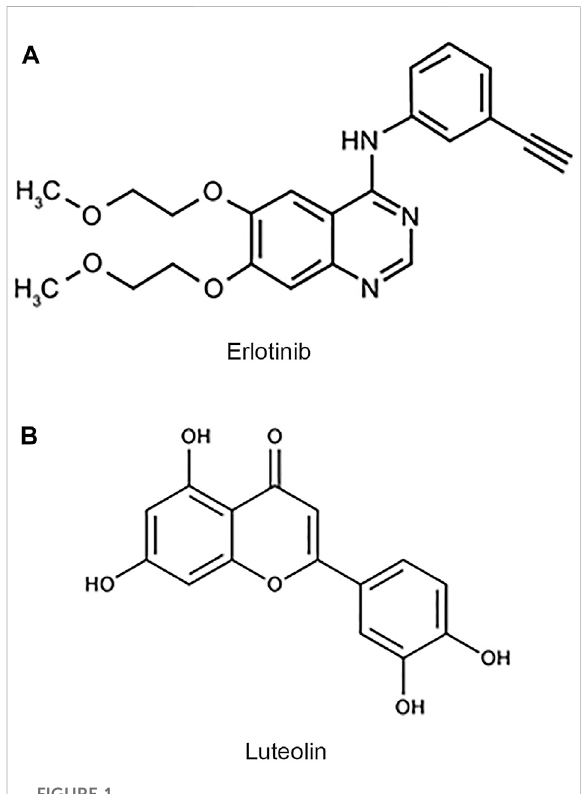
FIGURE 1 Chemical structures of erlotinib and luteolin. (A) Chemical structure of erlotinib, a small molecule inhibitor of EGFR. (B) Chemical structure of luteolin, a fl avonoid derived from vegetable